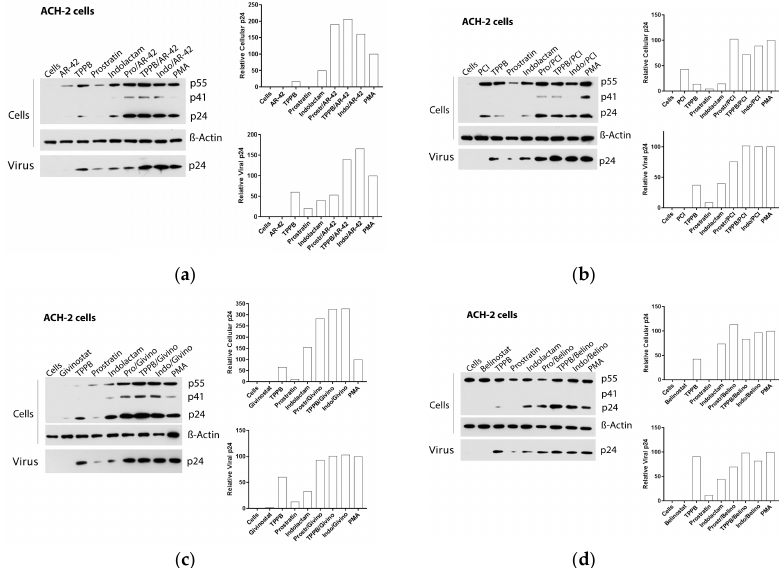
Figure 6. Effect of combinations of LRAs on the reactivation of latent HIV in ACH-2 cells. Immunoblot analysis of cell lysates and viral lysates and related densitometry analysis. β -actin was used as a loading control. The densitometry analysis of the cell-associated Gag p24 is relative to β -actin and expressed as a percentage of the positive control PMA set to 100. The densitometry analysis of the virion-associated Gag p24 is relative to the untreated control cells and expressed as a percentage of the positive control PMA set to 100. Immunoblots are representative of two independent experiments. A representative study of ( a ) AR-42, ( b ) PCI, ( c ) givinostat, and ( d ) belinostat in combination with the PKCas.